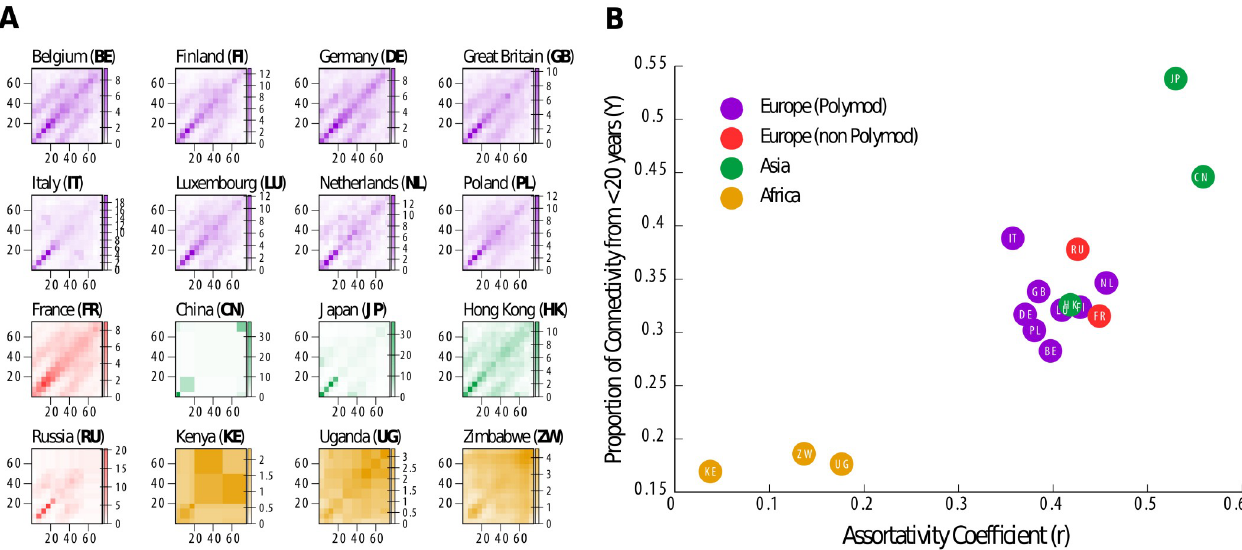
Fig 3. Geographical comparison of empirical contact matrices. A: Γ overall connectivity that comes from individual with less than 20 years (Y) vs the assortativity coefficient (r) for the 16 settings.